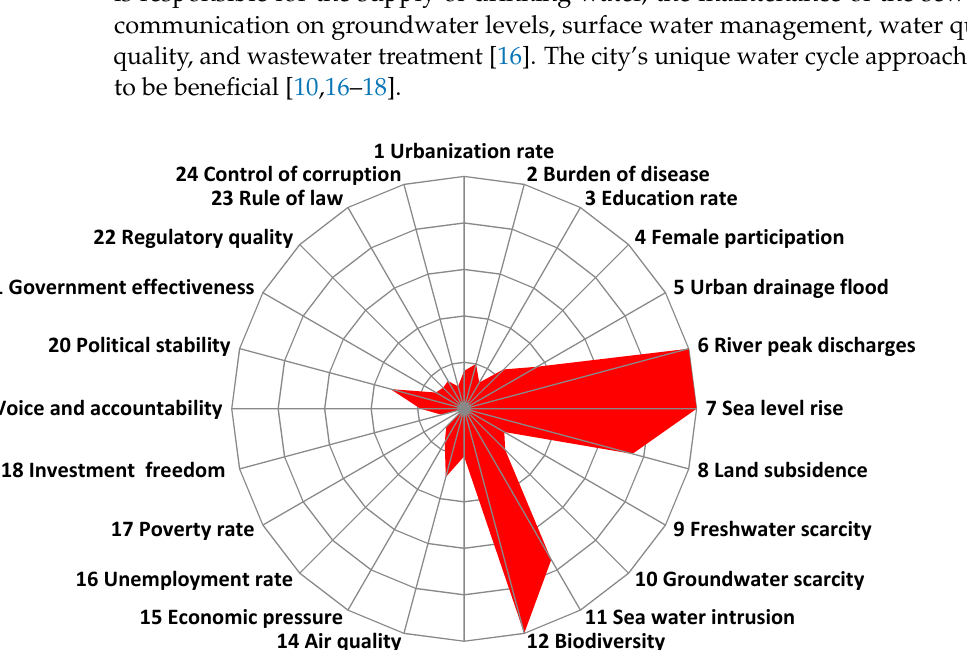
Figure 1. Aerial view of the city of Amsterdam showing the urban structure of the 17th century (Source: Office for Monuments and Archaeology, City of Amsterdam, photo by Cor Harteloh; with permission).